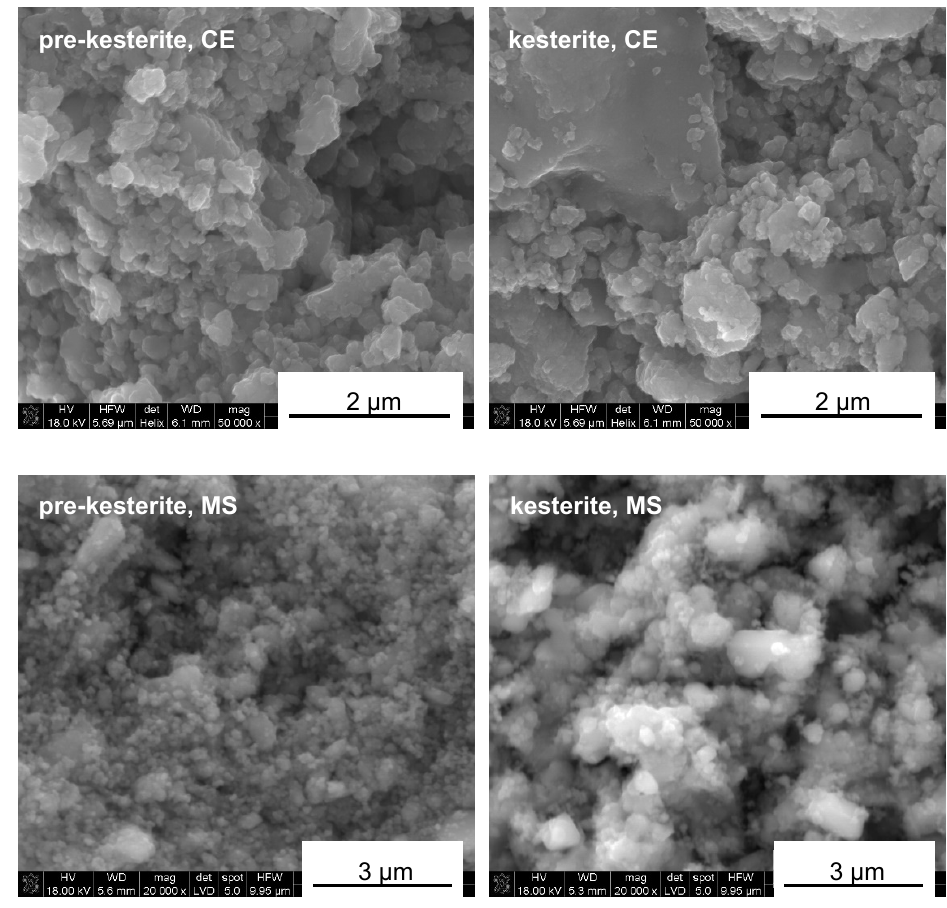
Figure 1. Typical nanopowder morphology, as examined by SEM for products in the CE system ( top row) and MS system ( bottom row).